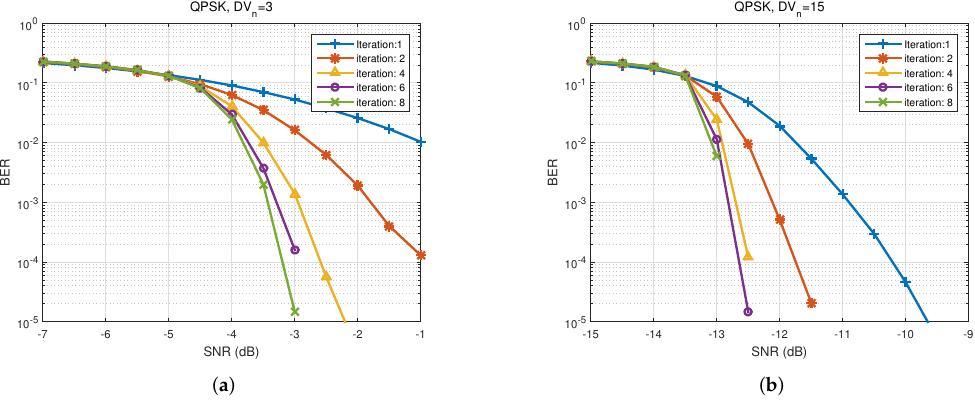
Figure 13. BER results for IoT PLC with QPSK modulation: ( a ) DV n = 3; and ( b ) DV n = 15.